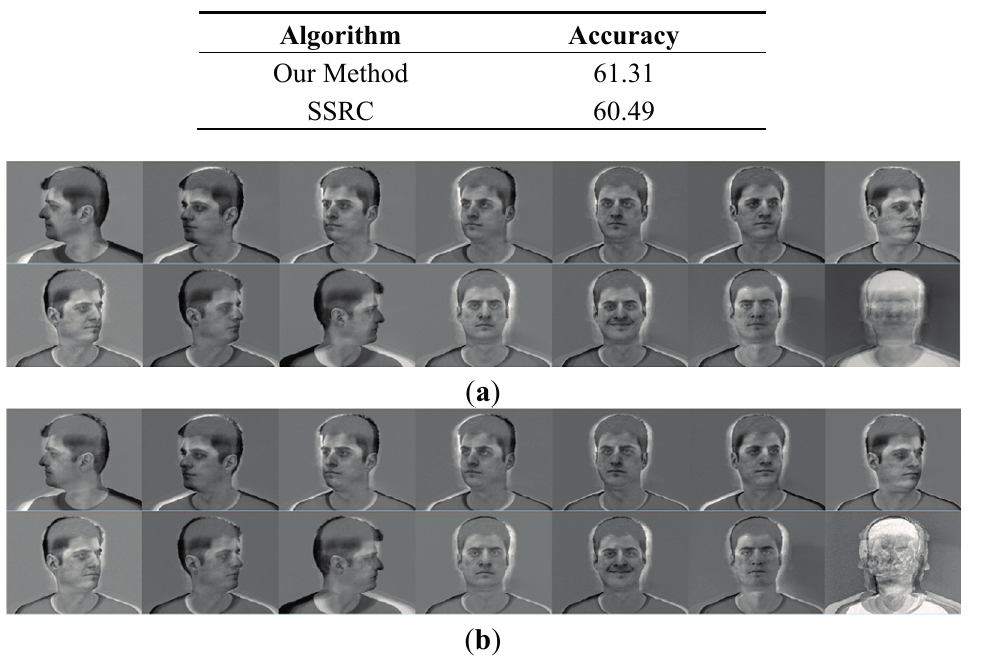
Table 7. Comparative recognition rates with 6 reference subjects on FEI database.